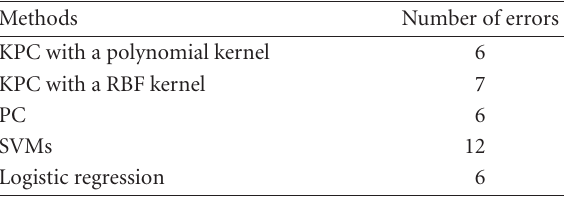
Table 5. Comparison for NCI.